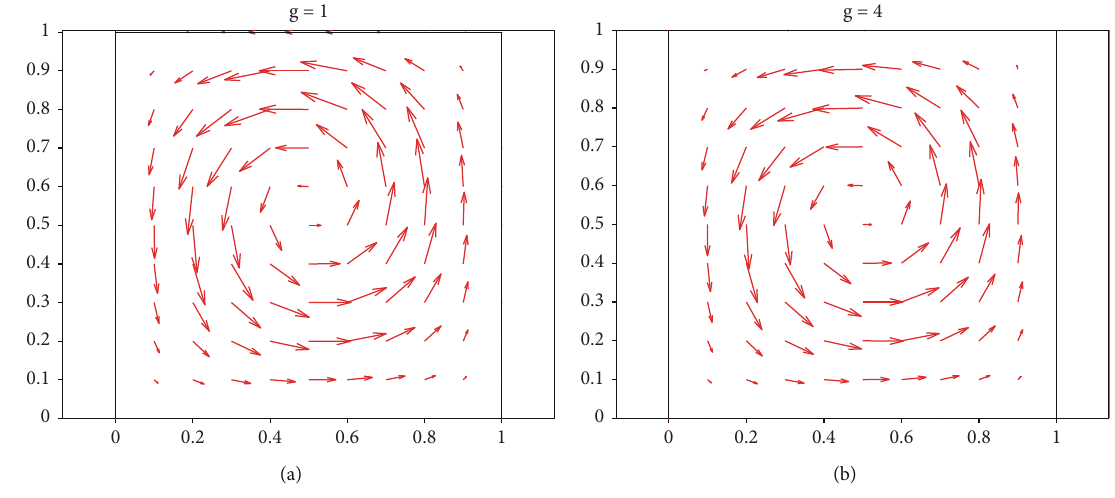
Figure 1: Velocity fi eld, respectively, for g = 1 and g = 4